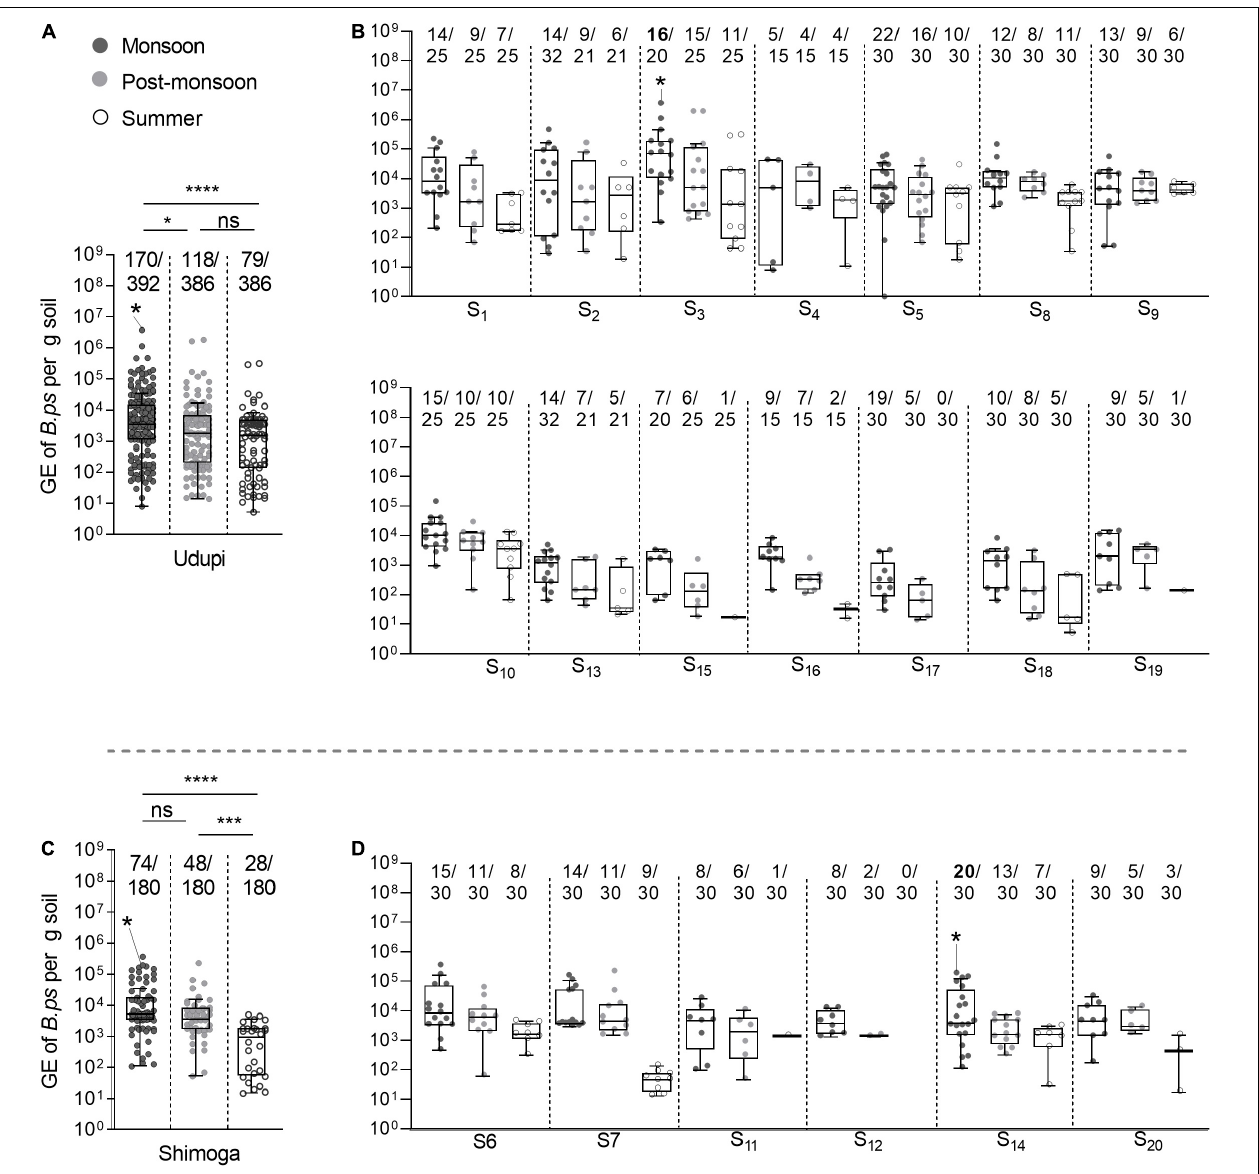
FIGURE 5 | Seasonal differences of B. pseudomallei burden in soil samples. (A,B) The B. pseudomallei burden of qPCR positive samples throughout the seasons of Udupi and its single sites (Kruskal–Wallis, * p < 0.05, *** p < 0.001, **** p < 0.0001). (C,D) Burden of B. pseudomallei in positive detected soil samples collected at Shimoga and its sites. Samples that became positive in subsequent enrichment culture are marked with an asterisk in the data set. The measured molecular load of the culture positive soil samples was 3.76 × 10 6 genome equivalents in the sample of site S3 and 1.95 × 10 5 genome equivalent for site S14. Boxes line values from the 25th to 75th percentiles of a data set; the vertical line in a box plot marks the median value. Whiskers from the lower and upper quartile represent 1.5 times the interquartile